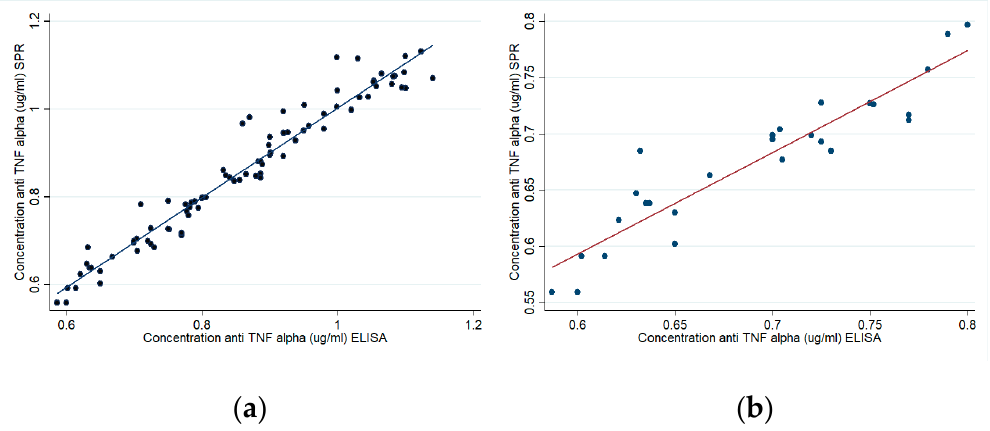
Figure 7. Correlating SPR and ELISA concentrations. ( a ) Patients (R 2 = 0.97) and ( b ) healthy volunteers (R 2 = 0.91) sample.